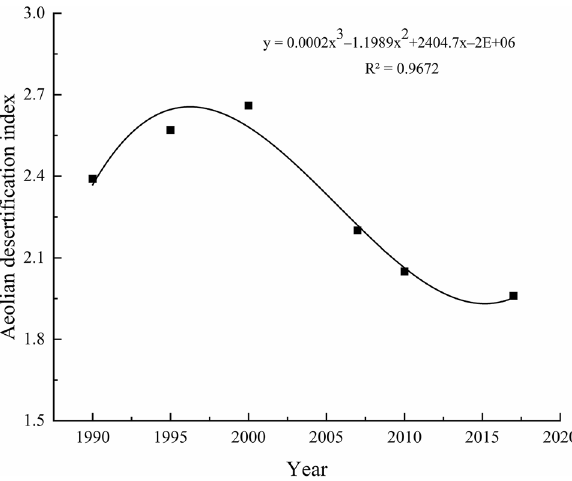
Figure 4. Changes of the desertification index in the study